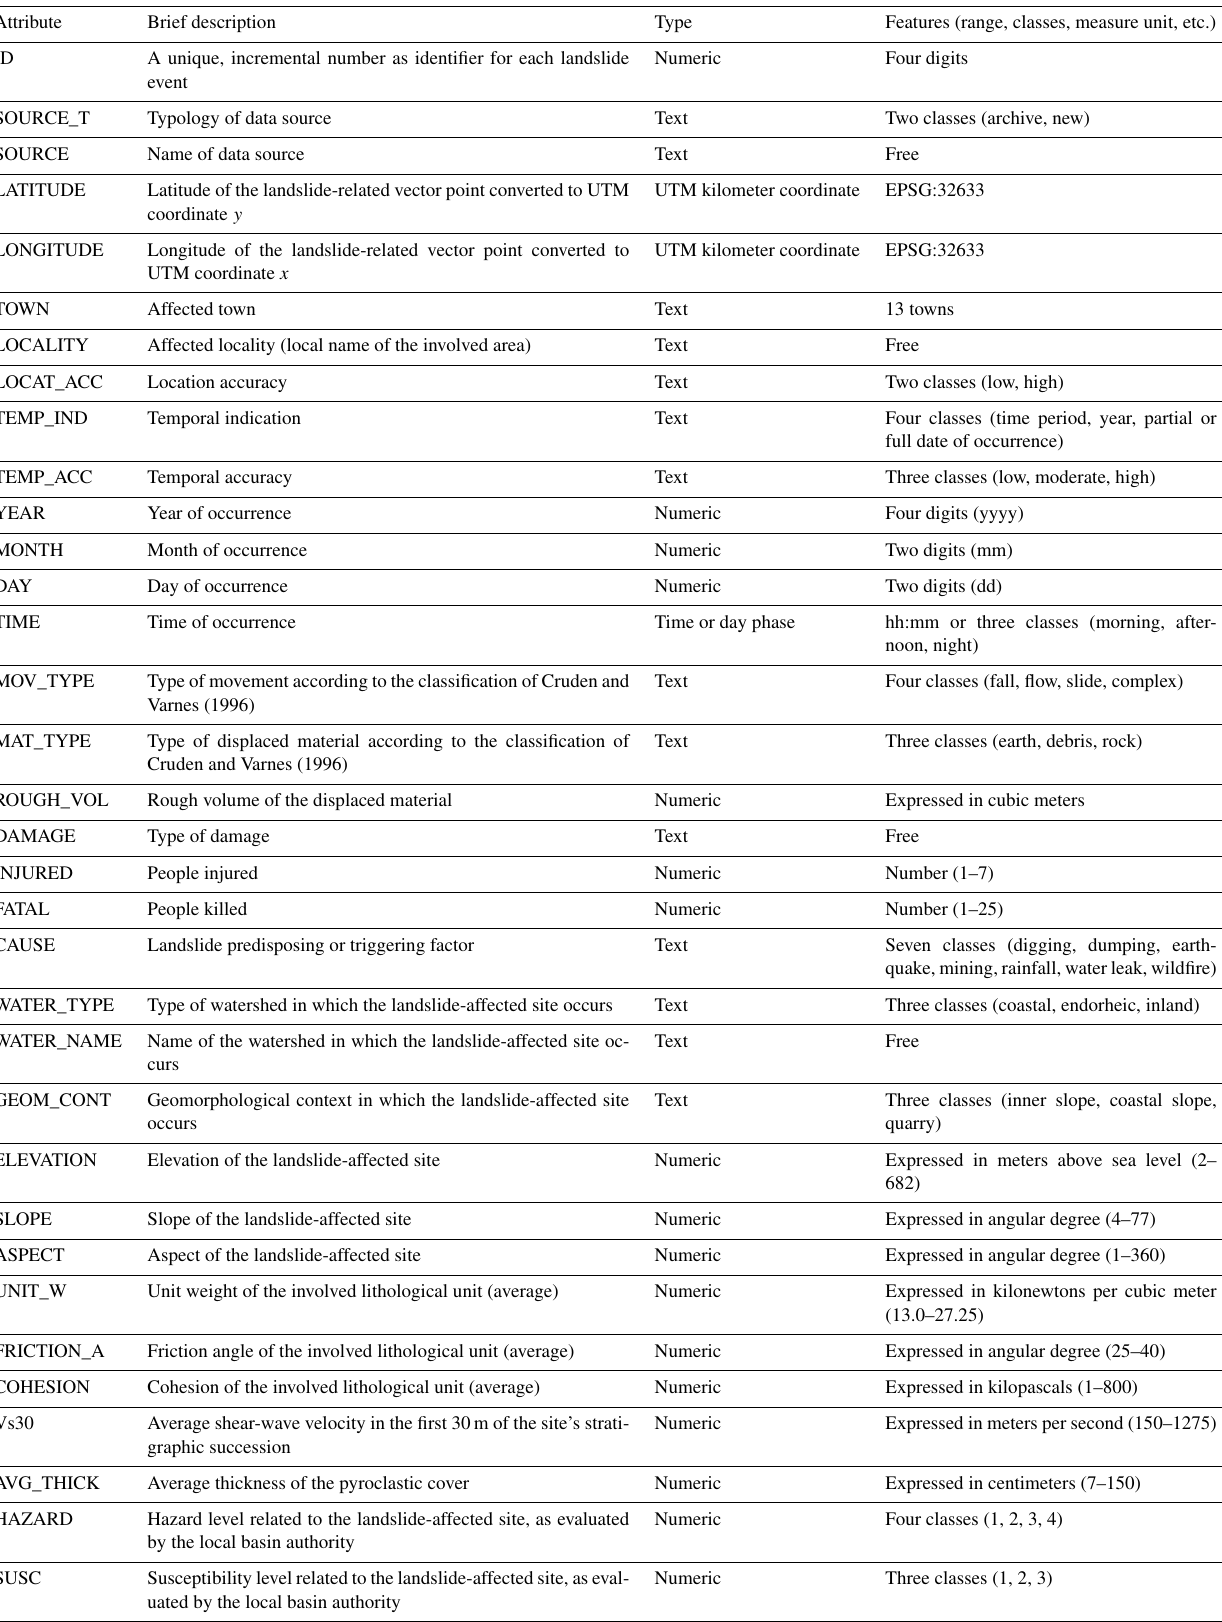
Table 1. Attribute list of the CAFLAG